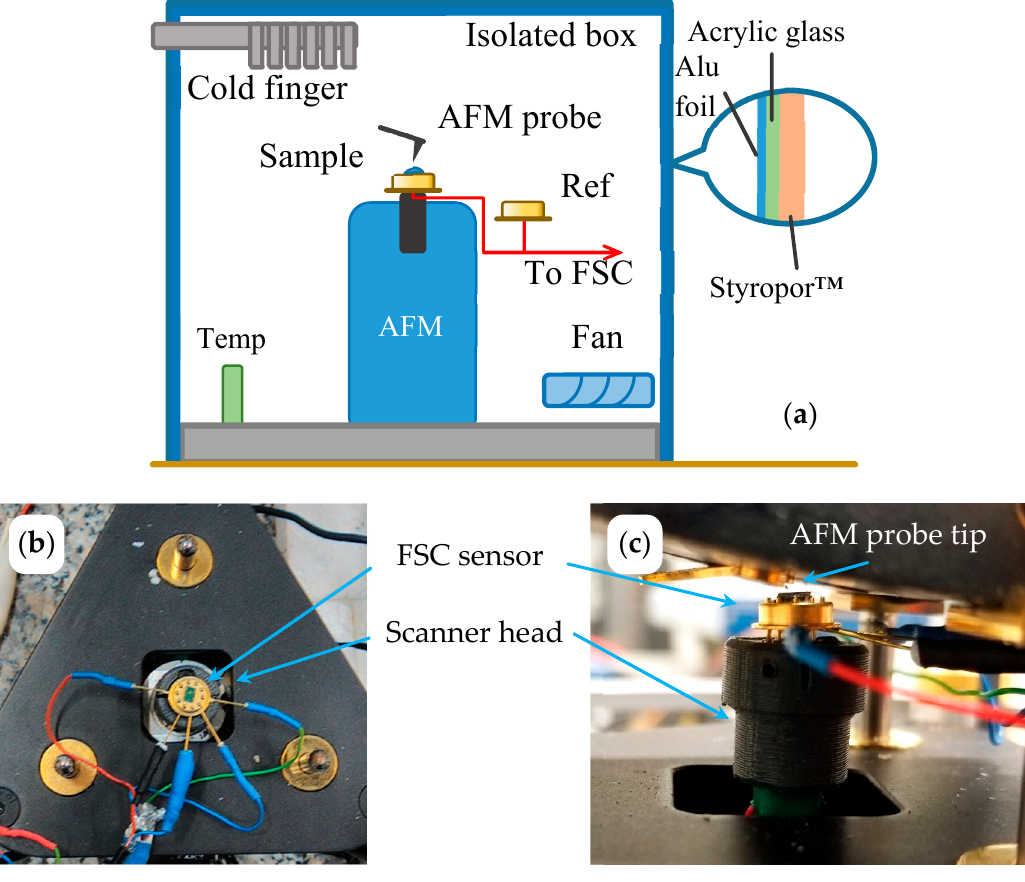
Figure 2. ( a ) Schematic view of the atomic force microscope fast scanning calorimeter (AFM-FSC) setup. ( b ) Photographs of the fast scanning calorimeter (FSC) sensor on the AFM scanner. ( c ) AFM probe approaching the sample on the sensor.